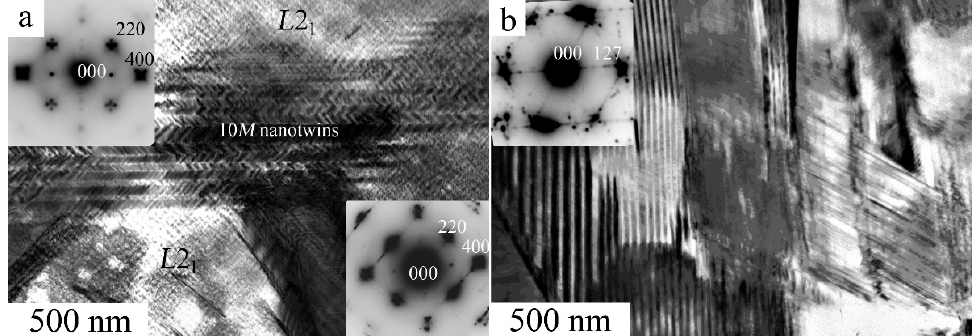
Figure 3. Bright-field TEM images of the microstructure of the cast alloy Ni 50 Mn 28.5 Ga 21.5 at ( a ) RT and ( b ) 120 K and the corresponding micro electron diffraction patterns (SAED, in the inserts). The SAED patterns correspond to residual L 2 1 austenite (zone axes (a.z.) [010] L 2 1 , insert on the left in Figure 3a), thin nanotwins of the 10 M (a.z. [010] 10 M , insert on the right in Figure 3a) and the 14 M (a.z. [111] former L 2 1 , insert in Figure 3b) martensite. The observations were performed at ( a ) RT and ( b ) 120 K.